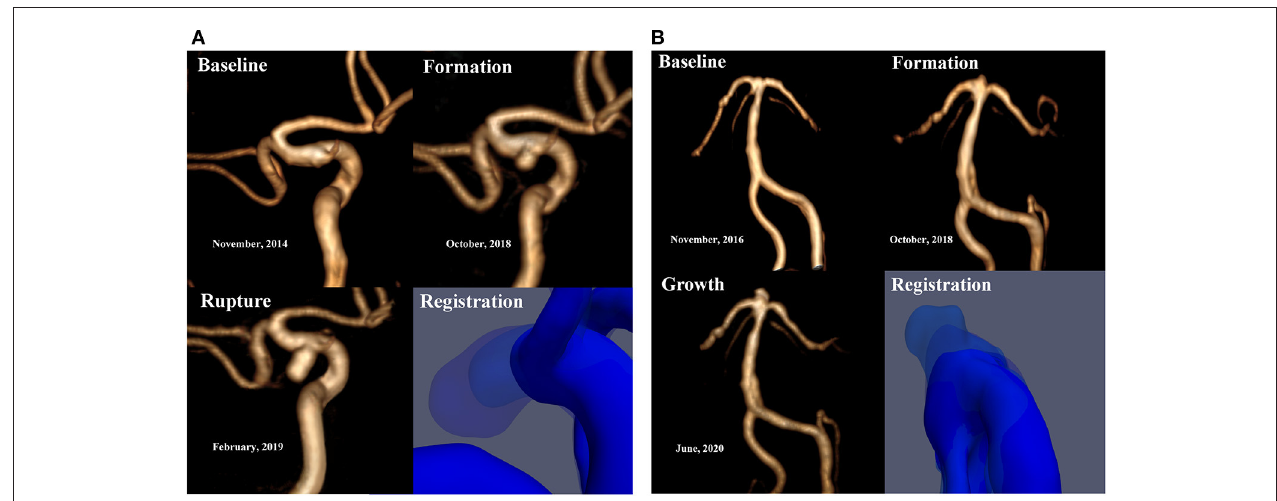
FIGURE 1 | (A) Patient 1 is a 56-year-old female. No significant abnormalities were observed by the baseline MRA. MRA reexamination about 4 years later showed a newly formed saccular aneurysm with a diameter of 3.2mm in the left posterior communicating artery. CTA showed that the aneurysm had significantly increased in size, reaching a diameter of 6.9mm. (B) Patient 2 is a 47-year-old female. No significant abnormalities were observed by the baseline MRA. A newly formed basilar tip aneurysm and aneurysmal enlargement were observed in the subsequent MRA examinations at follow-up (from 2.1 to 3.8mm in diameter). Registration of 3D surfaces with different degrees of transparency showed changes on continuous follow-up